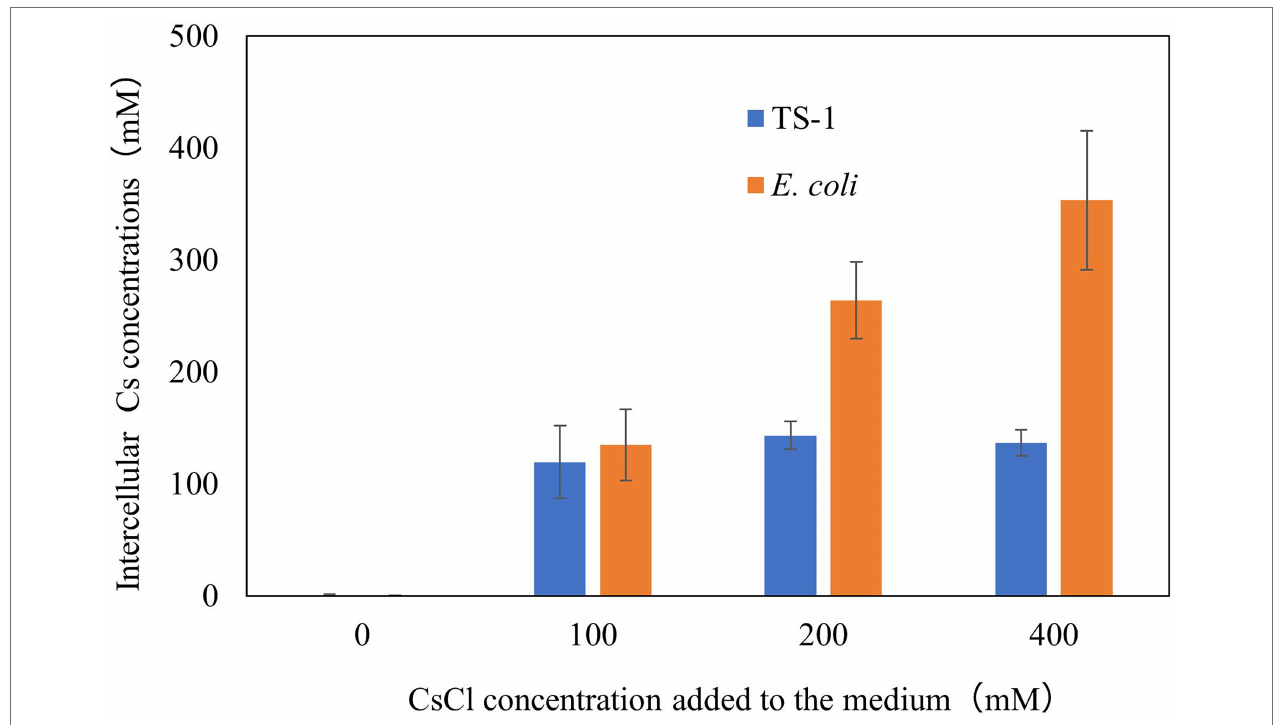
FIGURE 2 | Intracellular Cs + concentration of E. coli and strain TS-1 at several CsCl conditions. The details of the experiment are described in the Materials and Methods section. The error bars show the SD for two independent experiments.